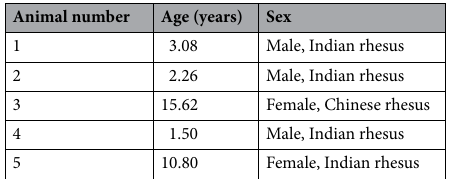
Table 1. Animals, strain and age used in this